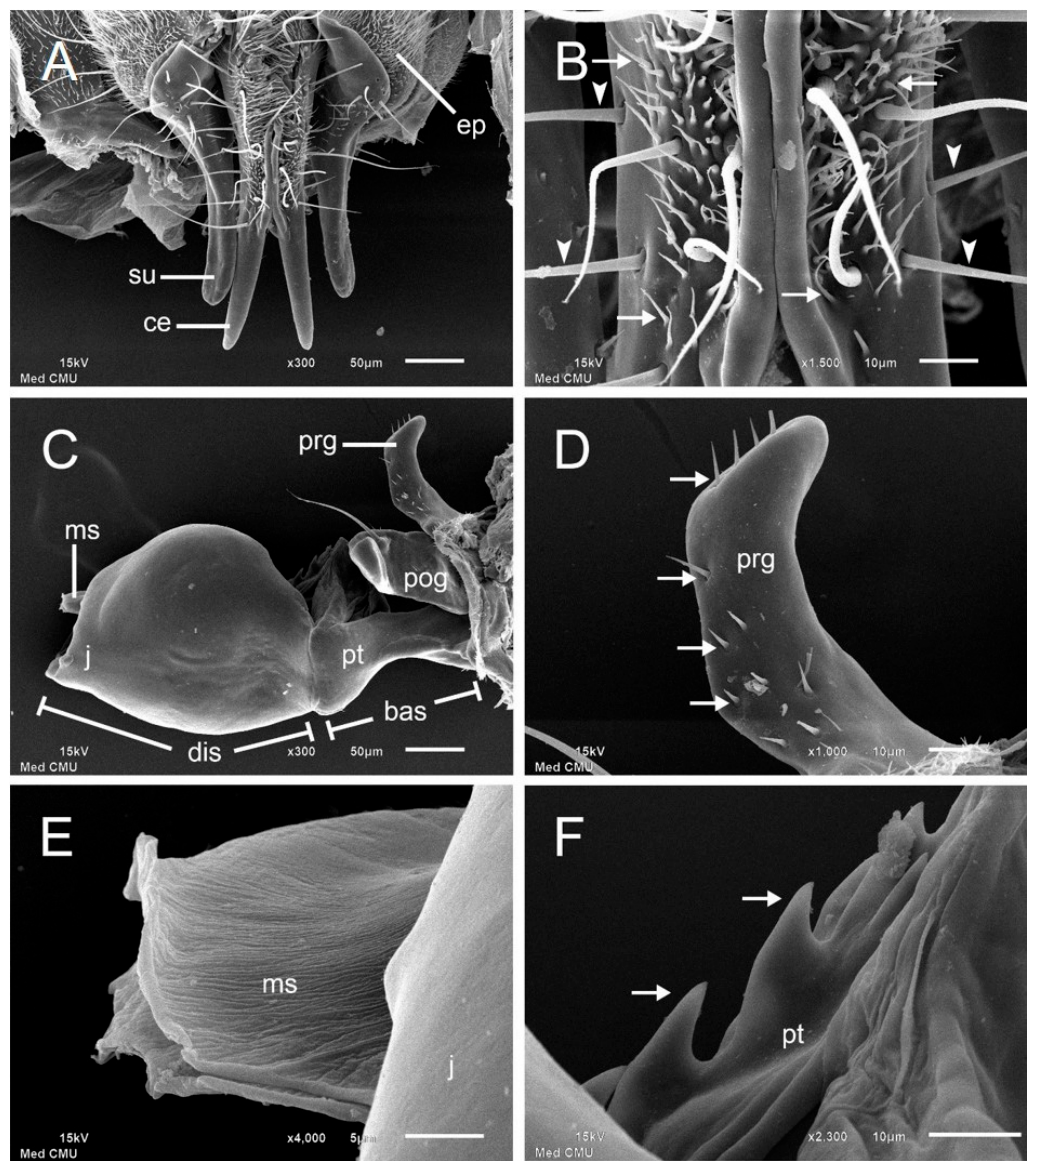
Figure 3. SEM micrographs of external male genitalia of Stomorhina discolor . ( A ) Posterior view of genitalia demonstrating prominent features: cercus (ce), surstylus (su), and epandrium (ep). Paired longitudinal cerci (ce) lie medial to the shorter surstyli (su); ( B ) High magnification of proximal portion of cerci showing sensilla trichodea of variable lengths (arrowheads) and sensilla basiconica with short hair shafts (arrows); ( C ) Lateral view of aedeagus showing pregonite (prg), postgonite (pog), phallic tube (pt), basiphallus (bas), distiphallus (dis), juxta (j), and median stylus (ms). The median stylus (ms) is inserted within the apically-oriented juxta (j). The pregonite (prg) and postgonite (pog) bearing a single bristle are prominent projections at the base; ( D ) High magnification of pregonite (prg) revealing sensilla basiconica with short hair shafts (arrows); ( E ) High magnification of median stylus (ms) with rough surface and expanded apex; ( F ) High magnification of phallic tube with dorsal serration (arrows) near center of aedeagus.